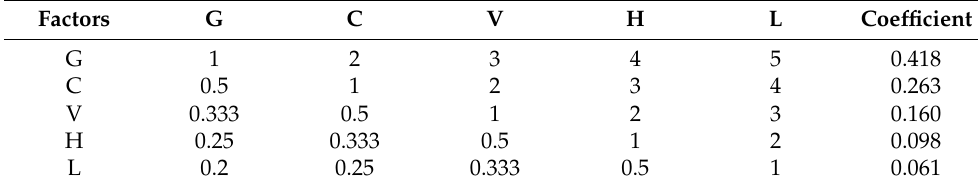
Table 2. Hierarchy of natural conditions by importance. Factors G C V H